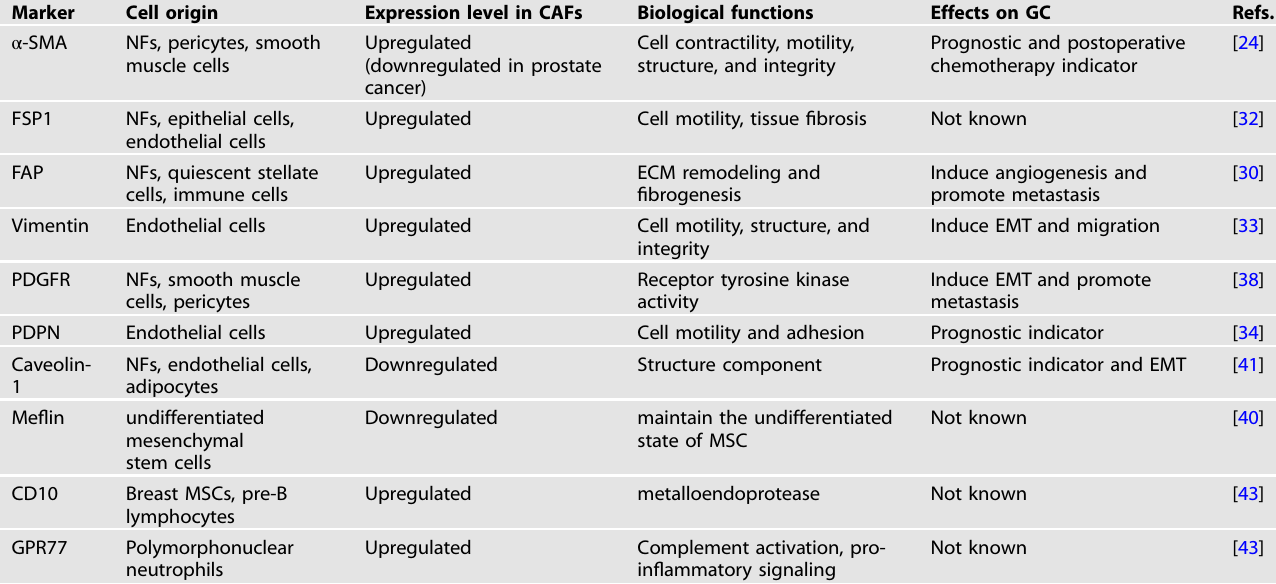
Table 1. Commonly used CAF